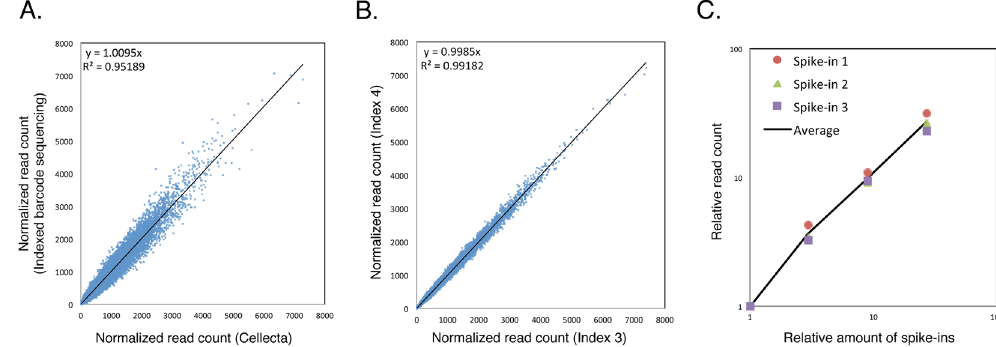
Figure 1. Reproducible and quantitative barcode amplification with indexed primers. ( A ) HeLa S3 cells transduced with Human Module 1 library were selected with puromycin for 2 days, cultured without the test compounds for an additional 10 days, and then harvested. An aliquot of the cells was sent to Cellecta for DNA extraction, PCR amplification without index tags, and barcode quantitation by deep sequencing. For index-tagged barcode amplification, genomic DNA was isolated from another aliquot of cells, and the barcode regions were amplified. Different index tags were added by the second PCR step, as described in Experimental Procedures and Supplementary Fig. S1. Four samples were combined in a single deep sequencing lane, and barcode sequencing was performed. Normalized read counts of each barcode from one of the samples (y-axis) were compared with those obtained from independent sequencing by Cellecta (x-axis). ( B ) HeLa S3 cells transduced with the Human Module 3 library were cultured, and barcode sequencing with index tags was performed as in ( A ). Normalized read counts of each barcode from sequencing performed with two different index tags were compared with each other. ( C ) HeLa S3 cells transduced with the Human Module 1 library were cultured as in ( A ), and genomic DNA was isolated. Increasing amounts of three DNA spike-ins harboring designed barcodes were added to genomic DNA prior to PCR amplification. Normalized read counts of the designed barcodes were plotted against the amounts of spike-ins added. Averages were calculated using three